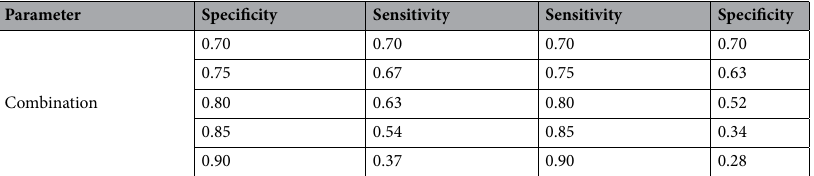
Table 4. Summary performance characteristics of the best-performing model (T2WI-derived radiomic features, PSA, and PSA density) from the leave-one-out cross validation results presented in Table 3. Depending on the clinical need, the predictive performance can be adjusted by prioritising specificity over sensitivity and vice versa, with the resulting parameter combinations presented in the